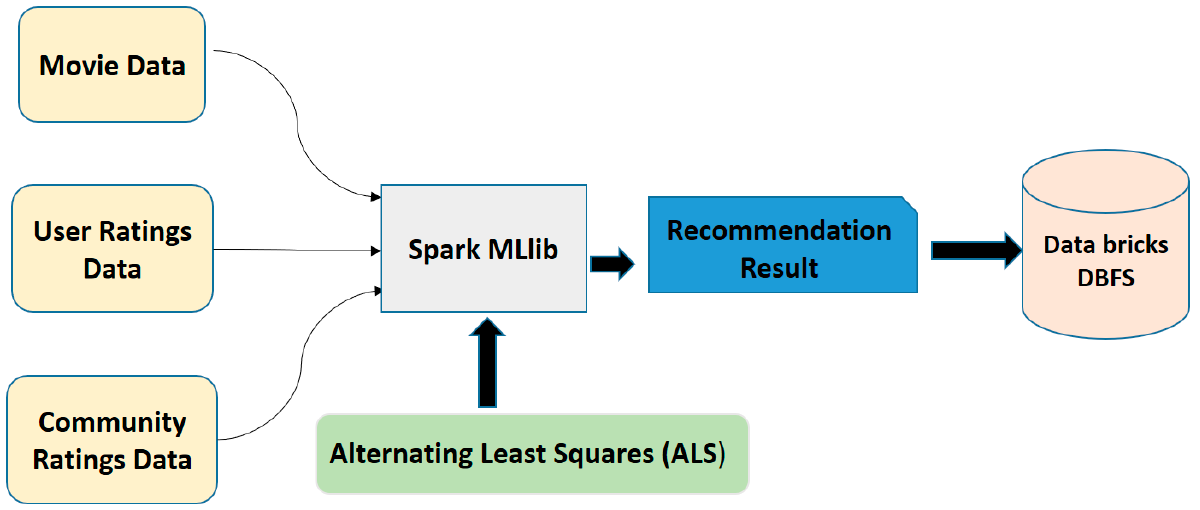
Figure 7. Block diagram of the proposed system using ALS through Apache Spark-MLlib.